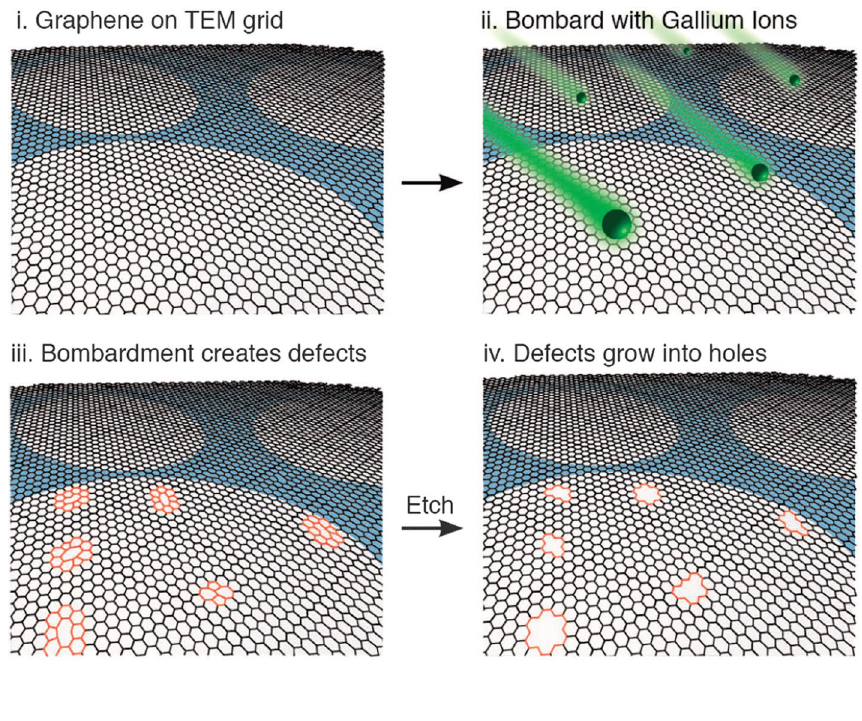
Fig. 5 Scanning electron microscopy image of a porous, b dense, c asymmetric and d symmetric inorganic membrane (Kayvani Fard et al. 2018)